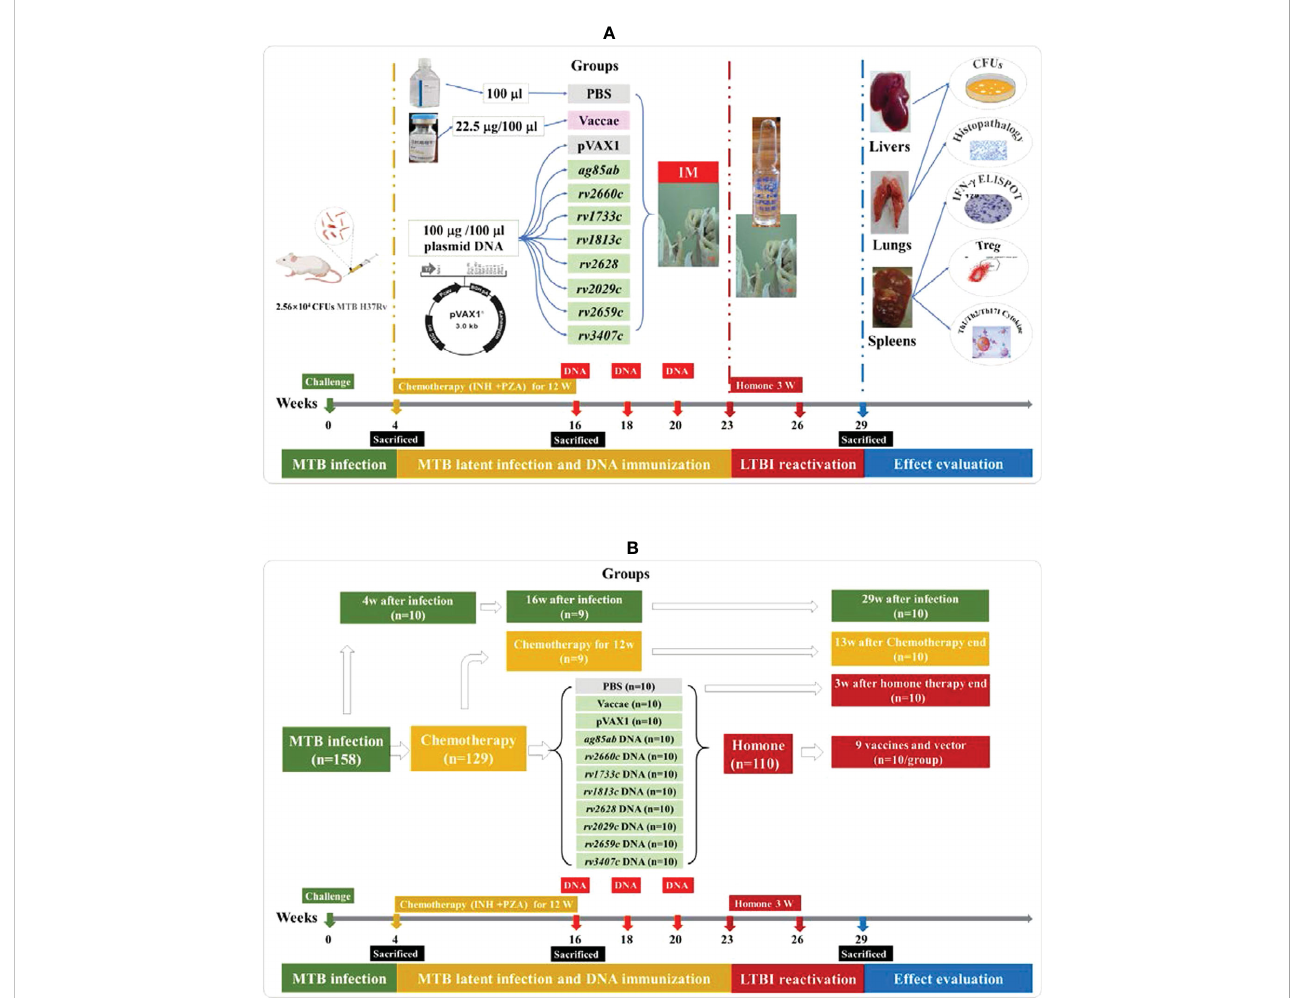
FIGURE 1 The experimental schedule and grouping diagram of this study. (A) the experimental schedule diagram of this study; (B) the grouping diagram of this